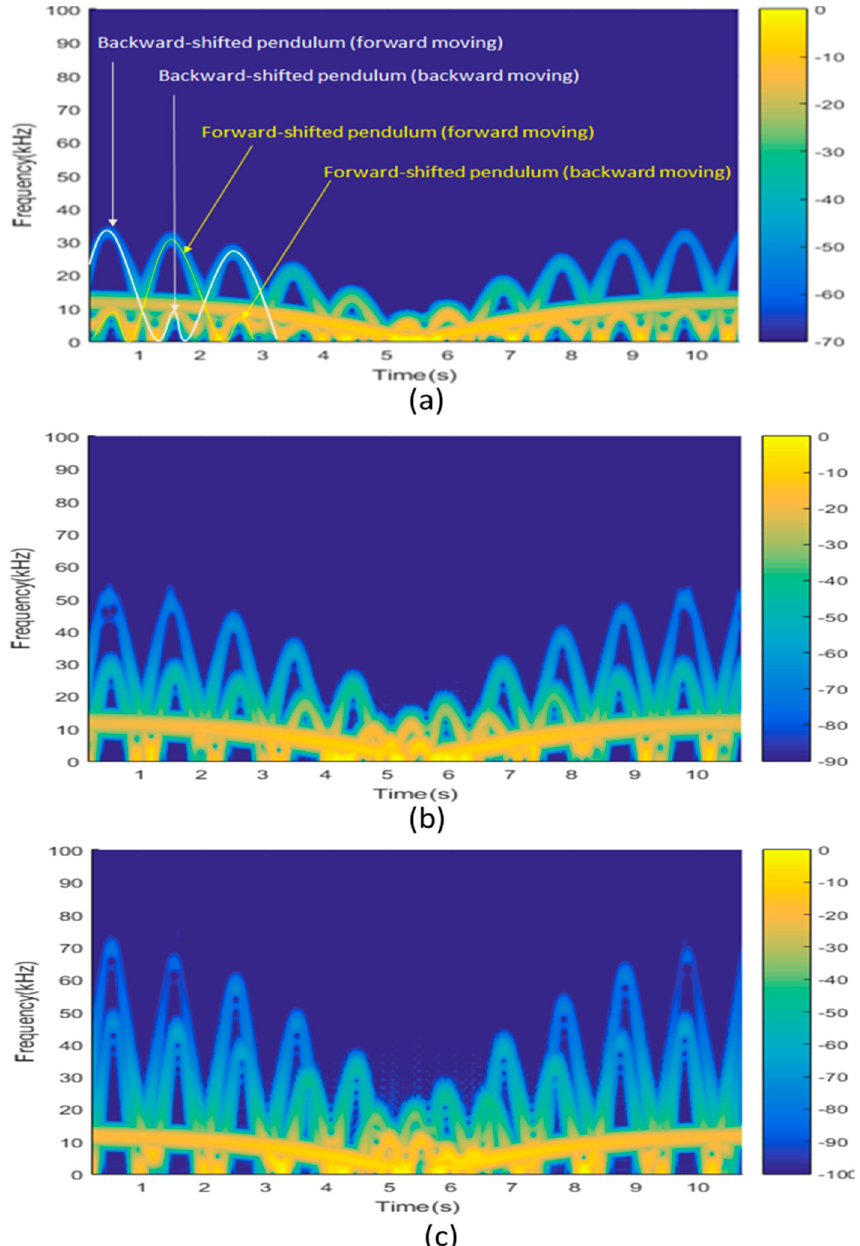
Figure 8. Simulation results for spectrogram of Doppler signature generated from two pendulums swing simultaneously in opposite direction with release angles, θ 0 at: ( a ) 20 ◦ ; ( b ) 40 ◦ ; and ( c ) 70 ◦